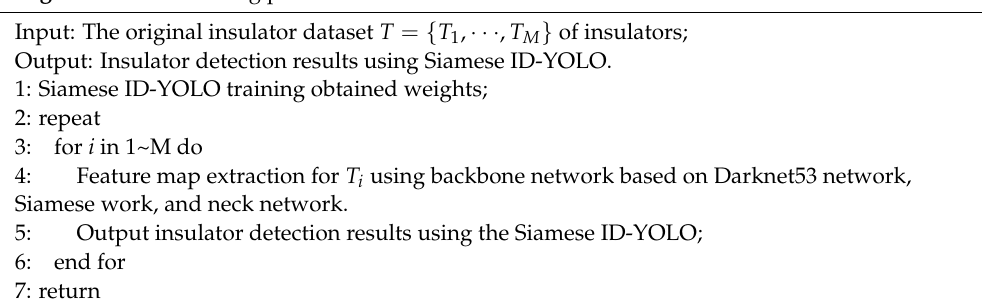
Algorithm 2. The testing process of Siamese ID-YOLO. Input: The original insulator dataset